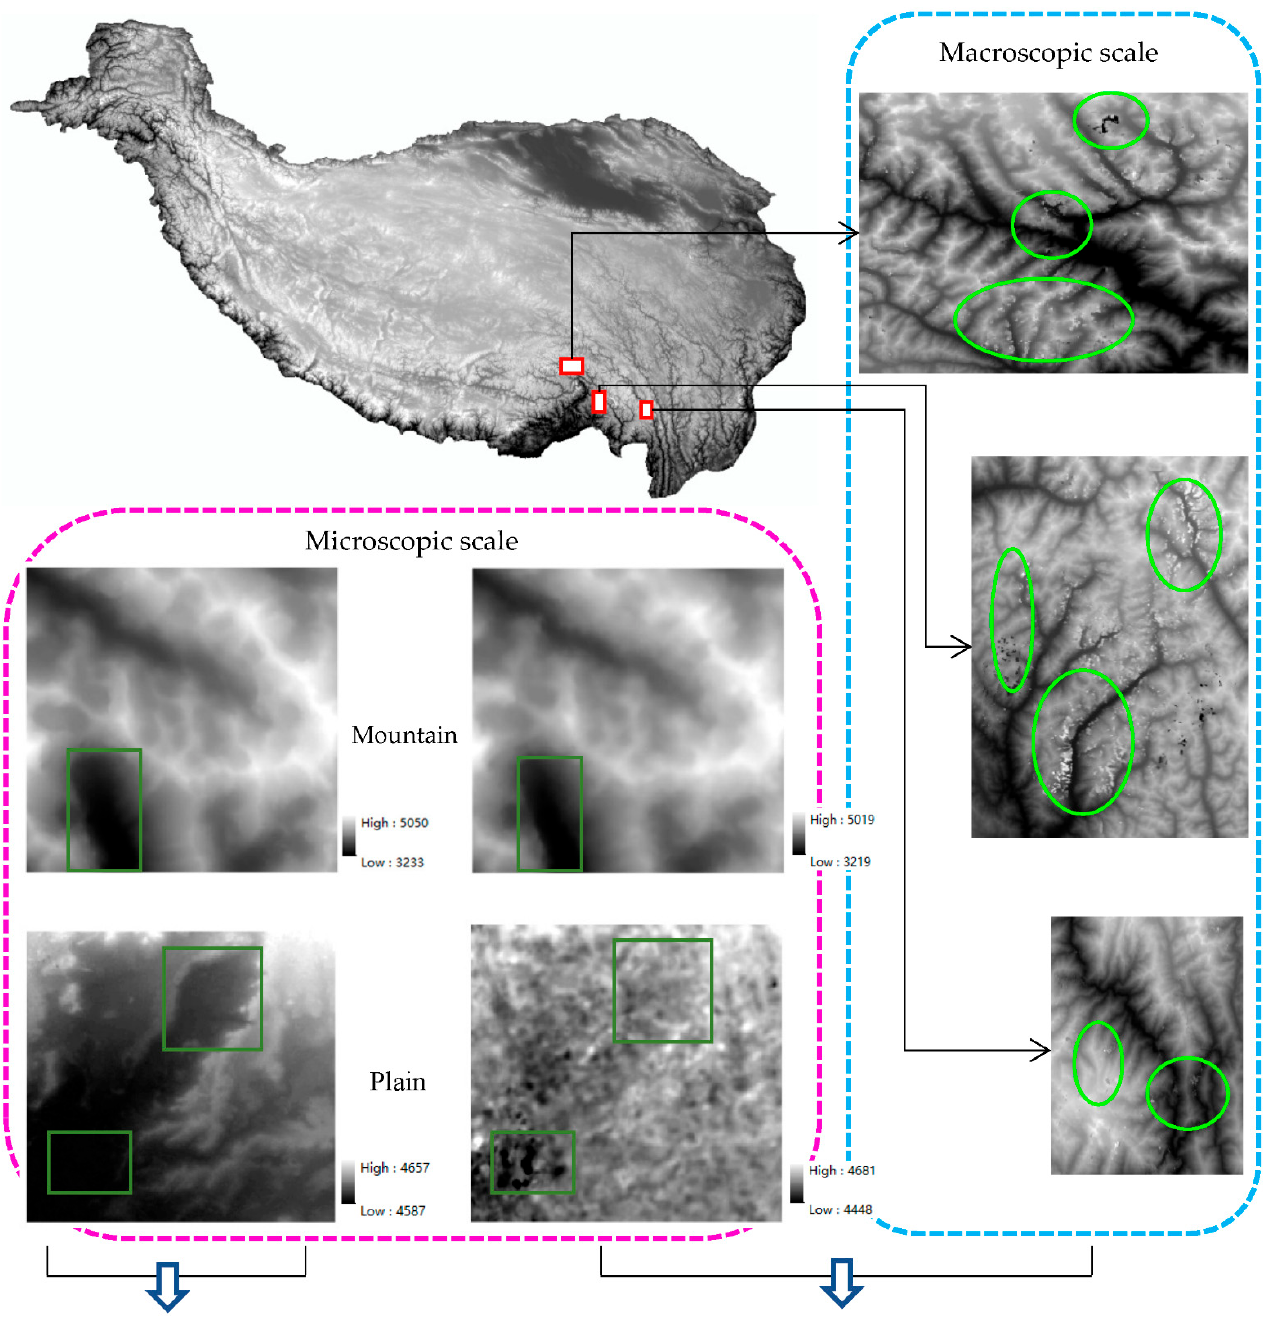
Figure 9. Detailed comparisons of AW3D30 DEM and ASTER GDEM texture images. ( a ) AW3D30 texture image; ( b ) ASTER GDEM texture image.